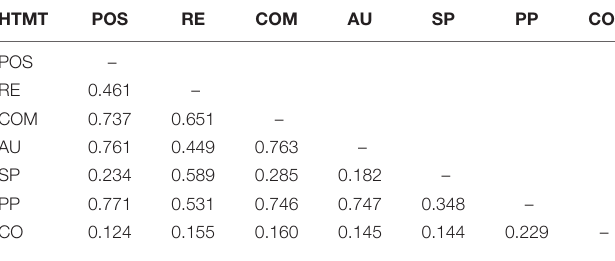
TABLE 3 | Results of heterotrait–monotrait (HTMT)